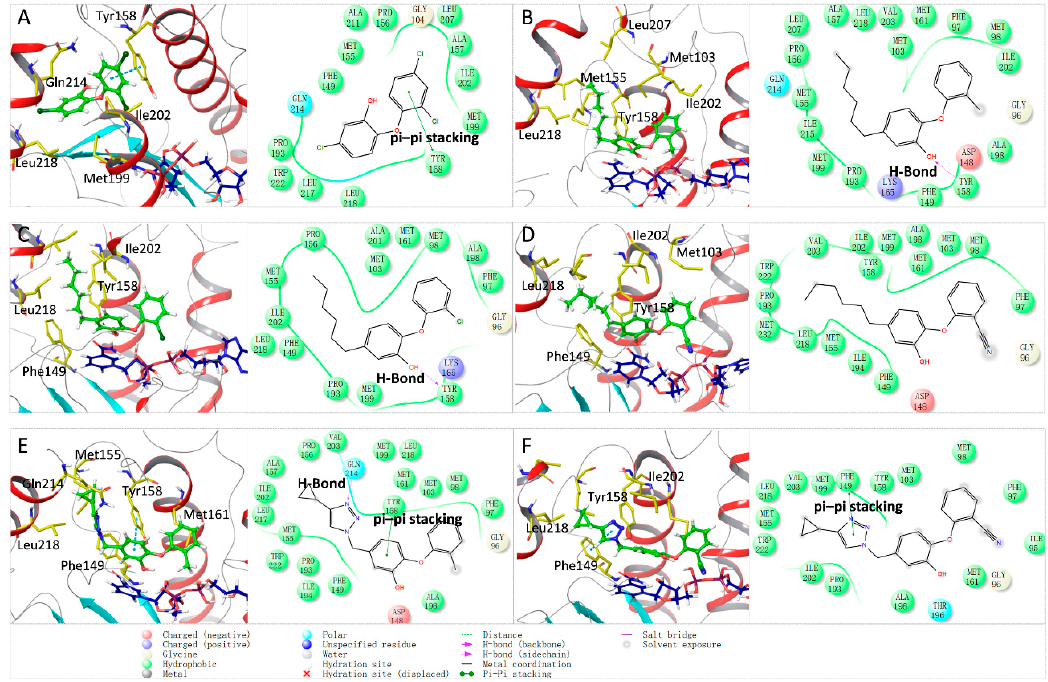
Figure 3. The detailed 3D and 2D binding mode for the representative conformation ( A ) TCL, ( B